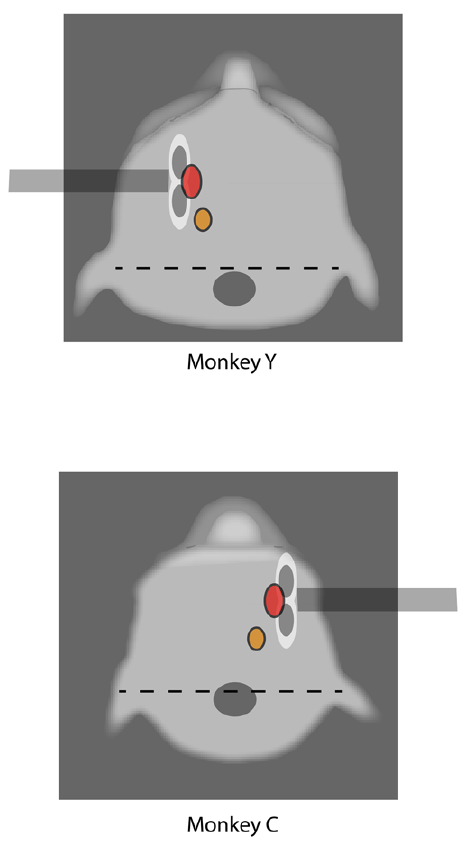
Figure 2. Schematic of TMS sites. Modified picture showing a top view of each of the two monkey’s scalp profiles (animals ‘Y’ and ‘C’), while posted and under training. The dotted line corresponds to the stereotaxic zero bar; the grey dot signals the location and size of the head-post; the orange dot corresponds to the location where digit movements were evoked by TMS pulses; the red dot FEF region of stimulation; the double white/grey dots is an approximate schematic representation of the TMS figure-of-eight coil which was located on the FEF region.